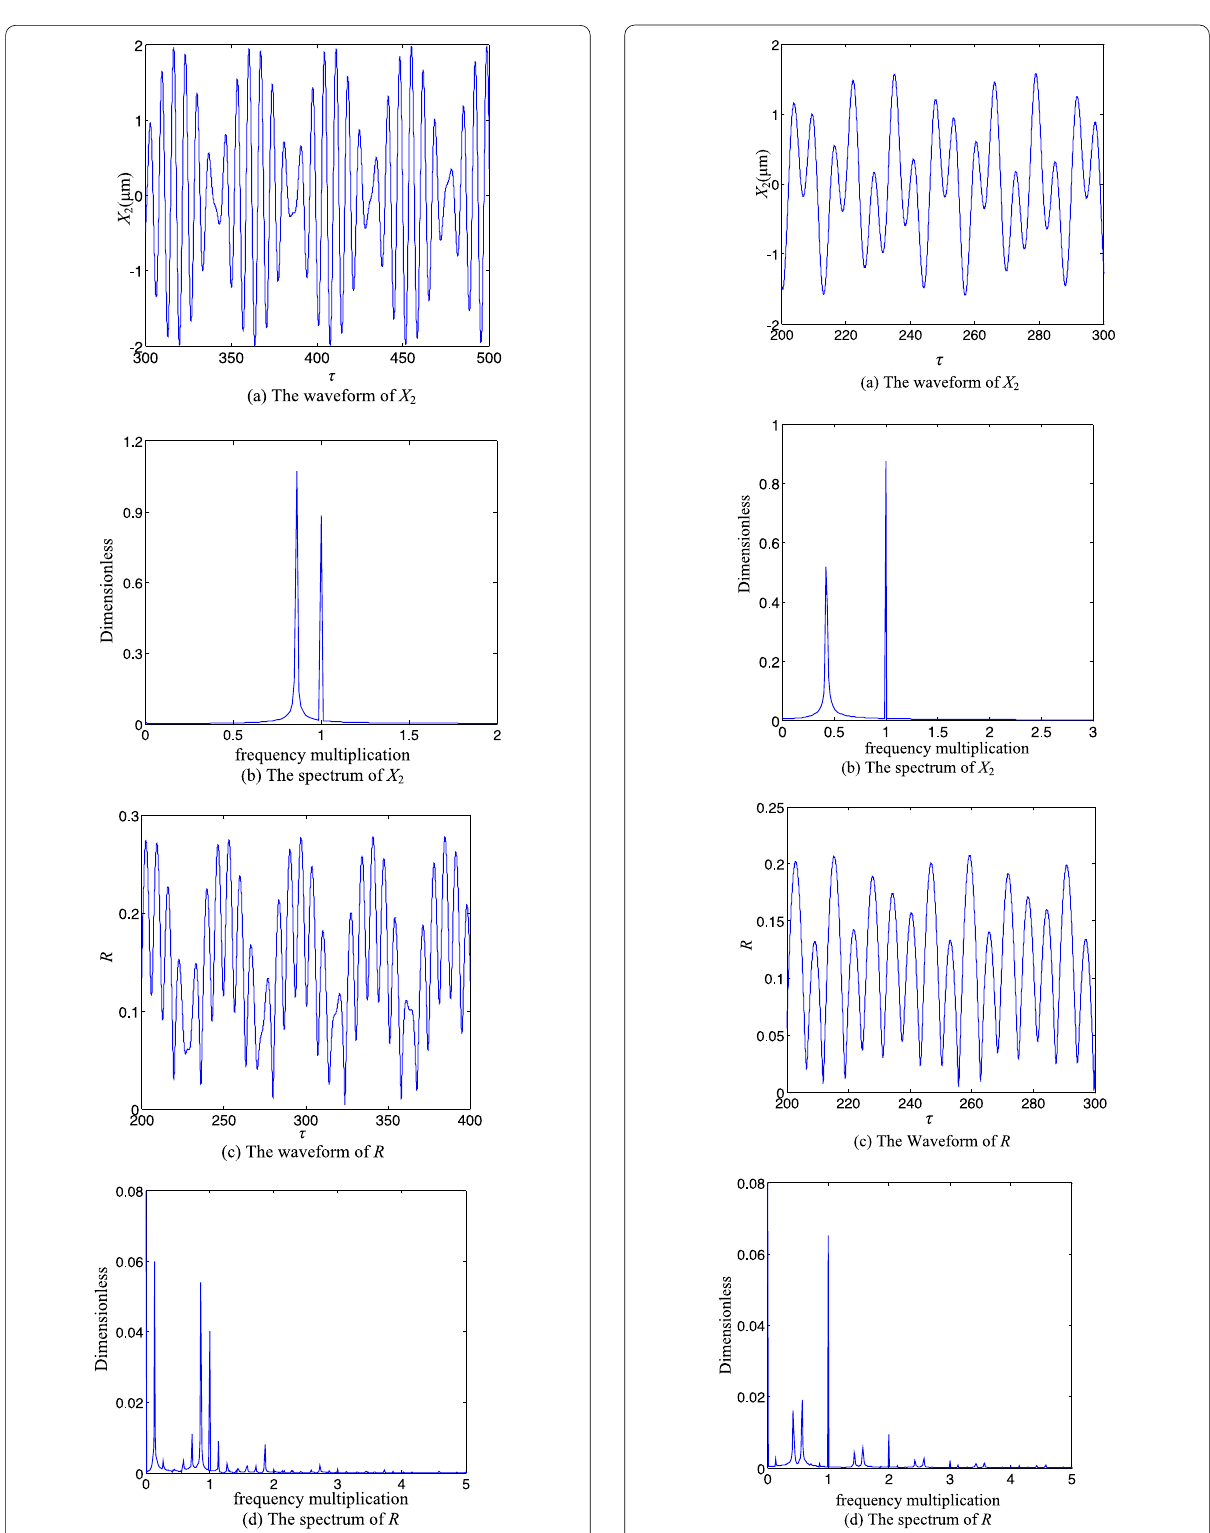
Figure 11 Time-frequency analysis when θ ′ 1 = 0.86 Figure 12 Time-frequency characteristics when θ ′ 1 =